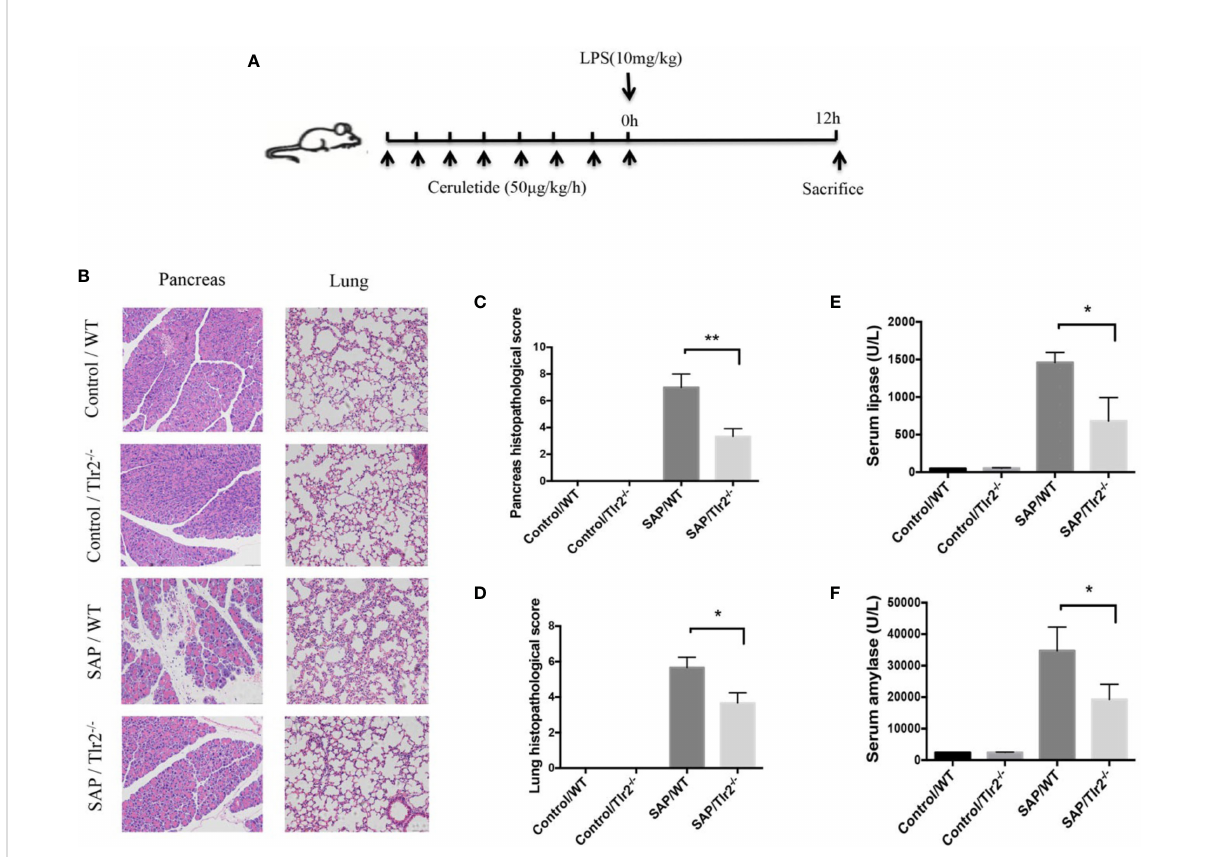
FIGURE 7 Tlr2 de fi ciency alleviated pancreatic and pulmonary injury in a SAP mouse model. (A) Illustration of the experimental protocol. (B) H&E staining of pancreas and lungs samples from wild-type (WT) and Tlr2 -/- mice (original magni fi cation, 200×). (C) Pancreatic injury scores were evaluated based on H&E staining. (D) Pulmonary injury scores were evaluated based on H&E staining. (E, F) Serum lipase and amylase levels in the WT and Tlr2 -/- groups are displayed. Data are shown as the mean ± SD ( n = 3/group). These data are representative of two independent experiments. * P < 0.05; ** P <